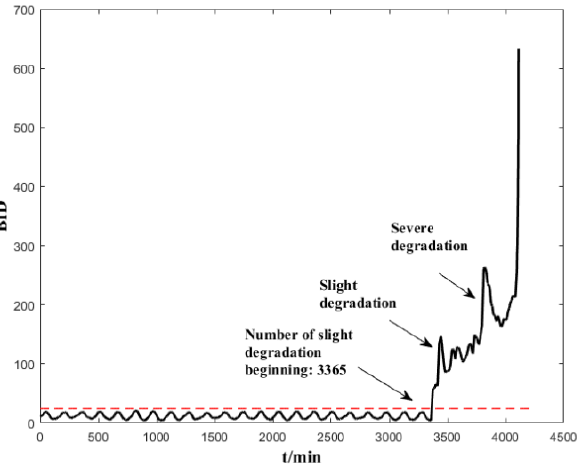
Figure 11. Performance assessment of the whole life time of B1 with vibration monitoring sensors.